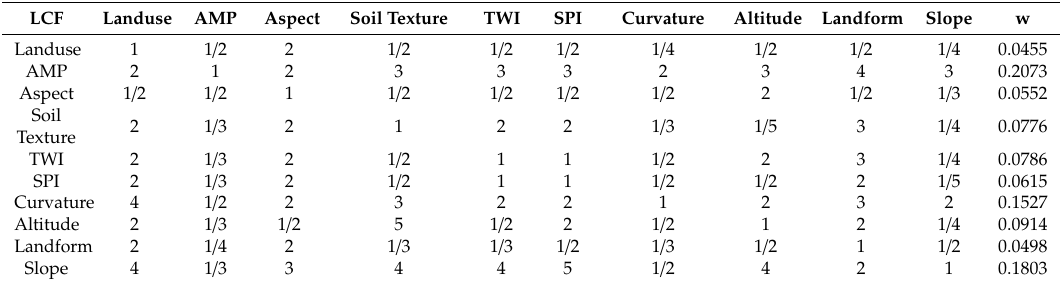
Table A1. Pairwise comparison matrix and normalized weight of ten LCFs using the conventional AHP.